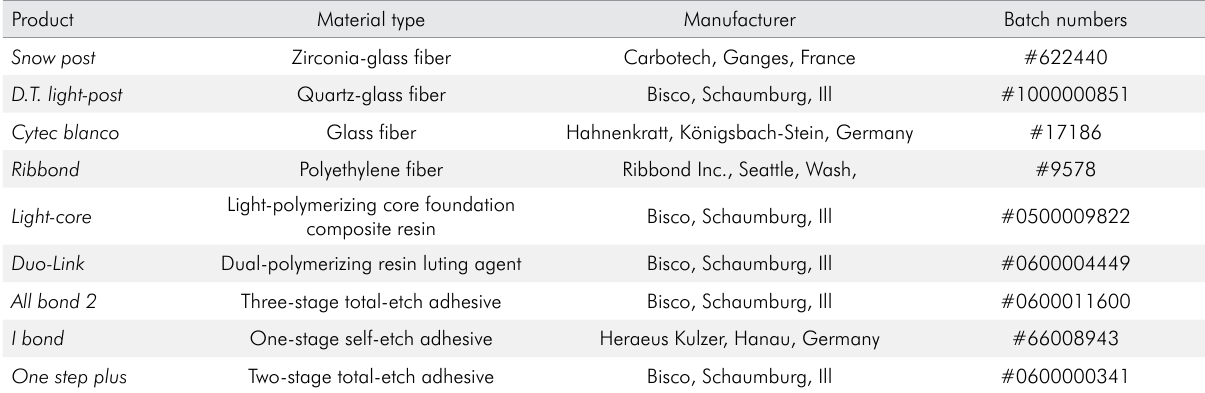
Table 1. Description of materials used in this study and information on the manufacturers.